Question: Write a single sentence explaining what this figure depicts.
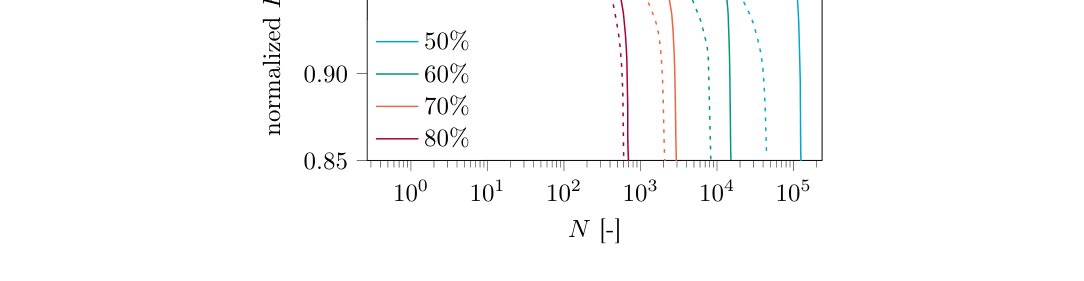
Answer: Stiffness reduction with number of cycles for four different severity levels. Dashed and solid lines correspond to the response with global and local stress ratio, respectively